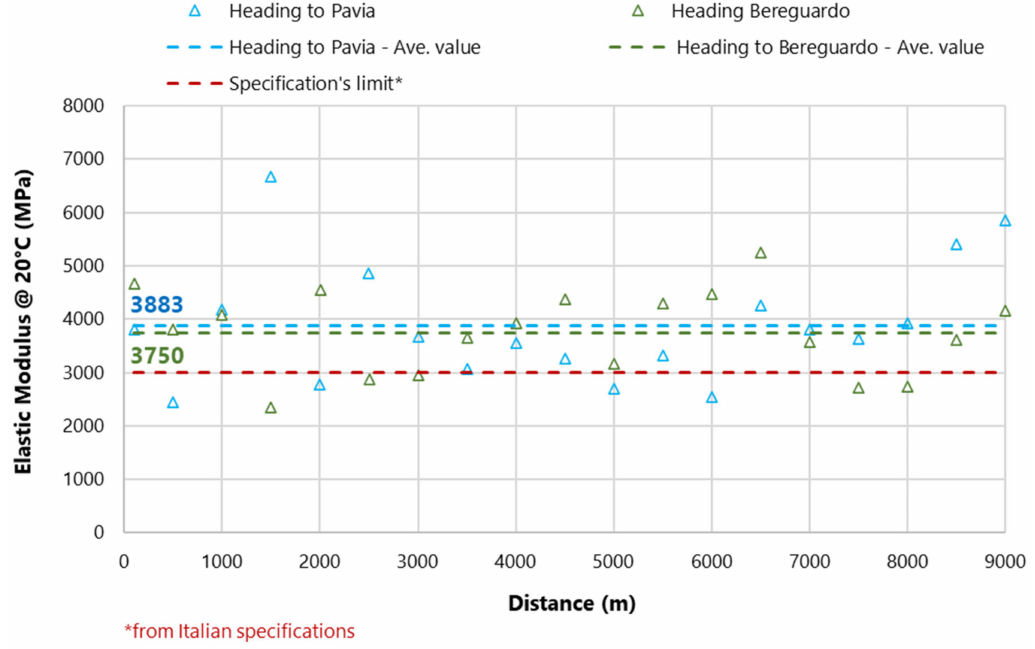
Figure 9. FWD E1 (asphalt layers) dynamic modulus after two years (2017) of installation of the